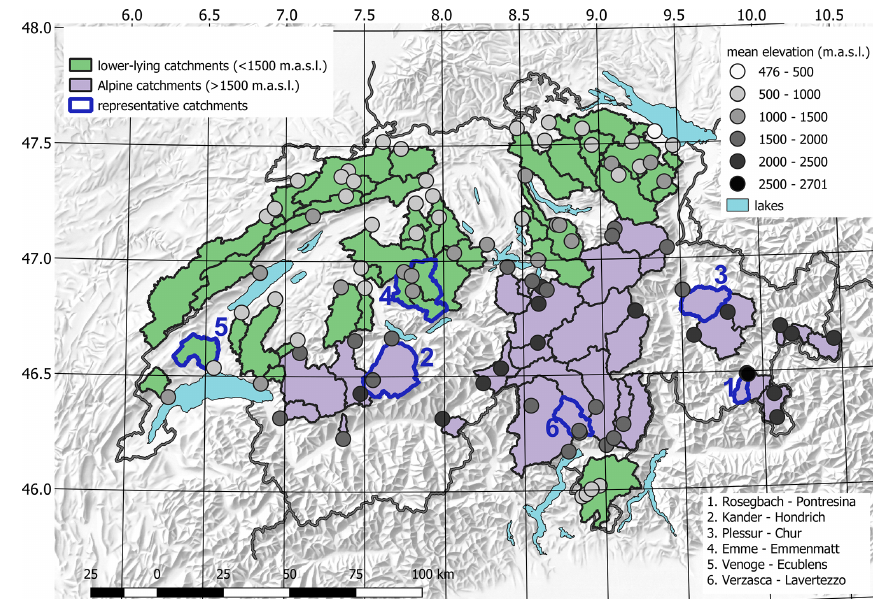
Figure 1. Overview of the study catchments and the location of the corresponding gauging stations (dots). Grey shading shows the mean elevation of a catchment. Catchments are divided into two groups: lower-lying catchments (green) and Alpine catchments (purple). Blue contours indicate the six example catchments: Rosegbach (1), Kander (2), Plessur (3), Emme (4), Venoge (5), and Verzasca (6).